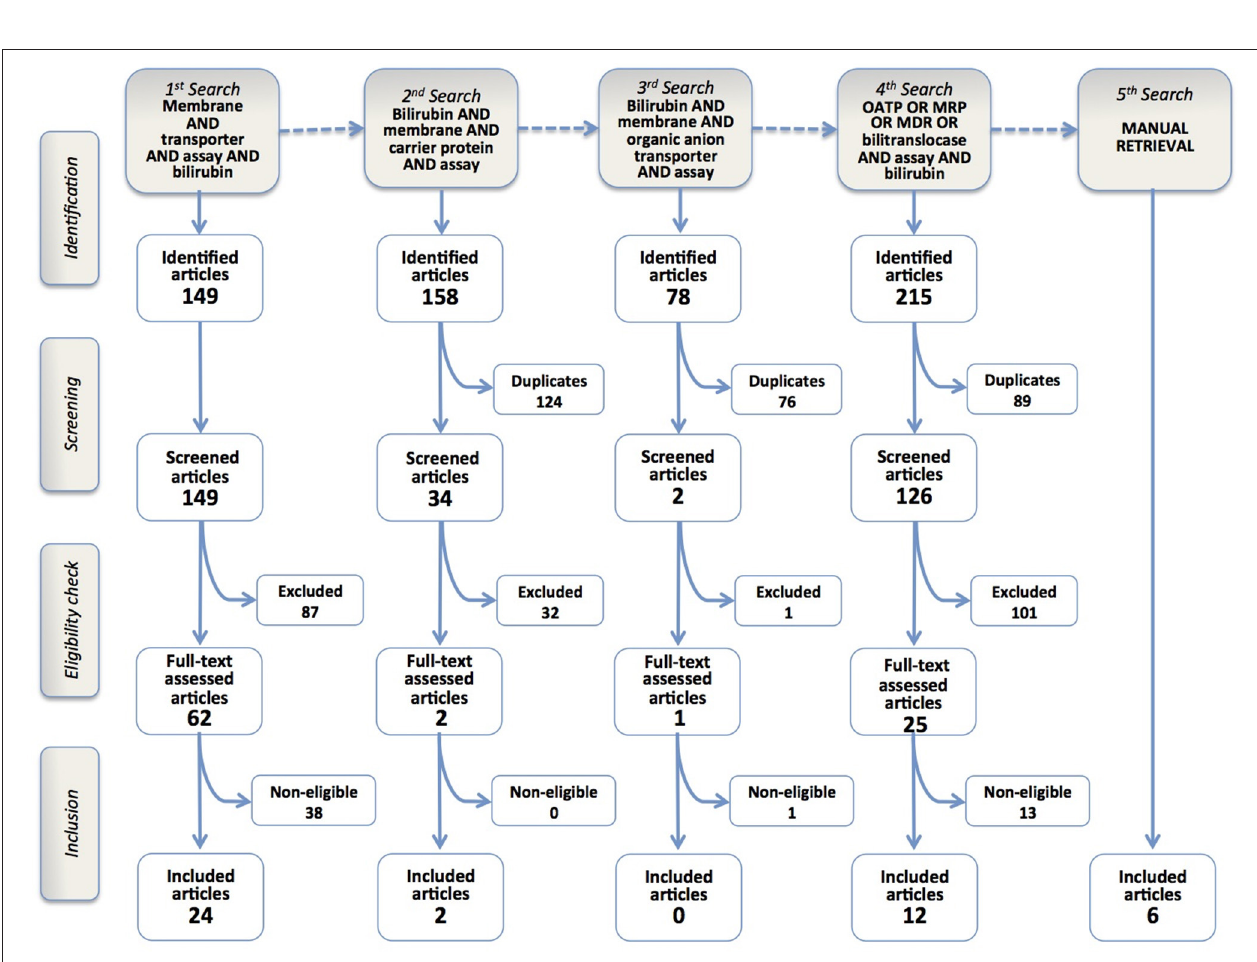
FIGURE 1 | Flowchart of the results of the literature search strategy and implementation of inclusion criteria. Four query-based searches and a manual one resulted in the inclusion of 44 articles.